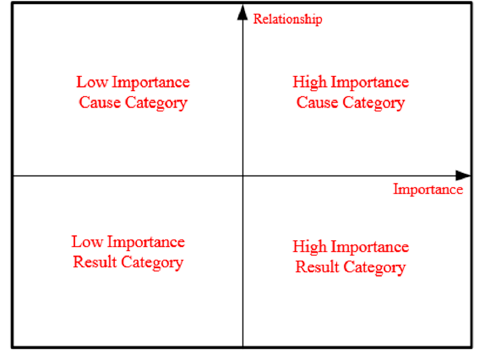
Figure 3. The importance–causality diagram.